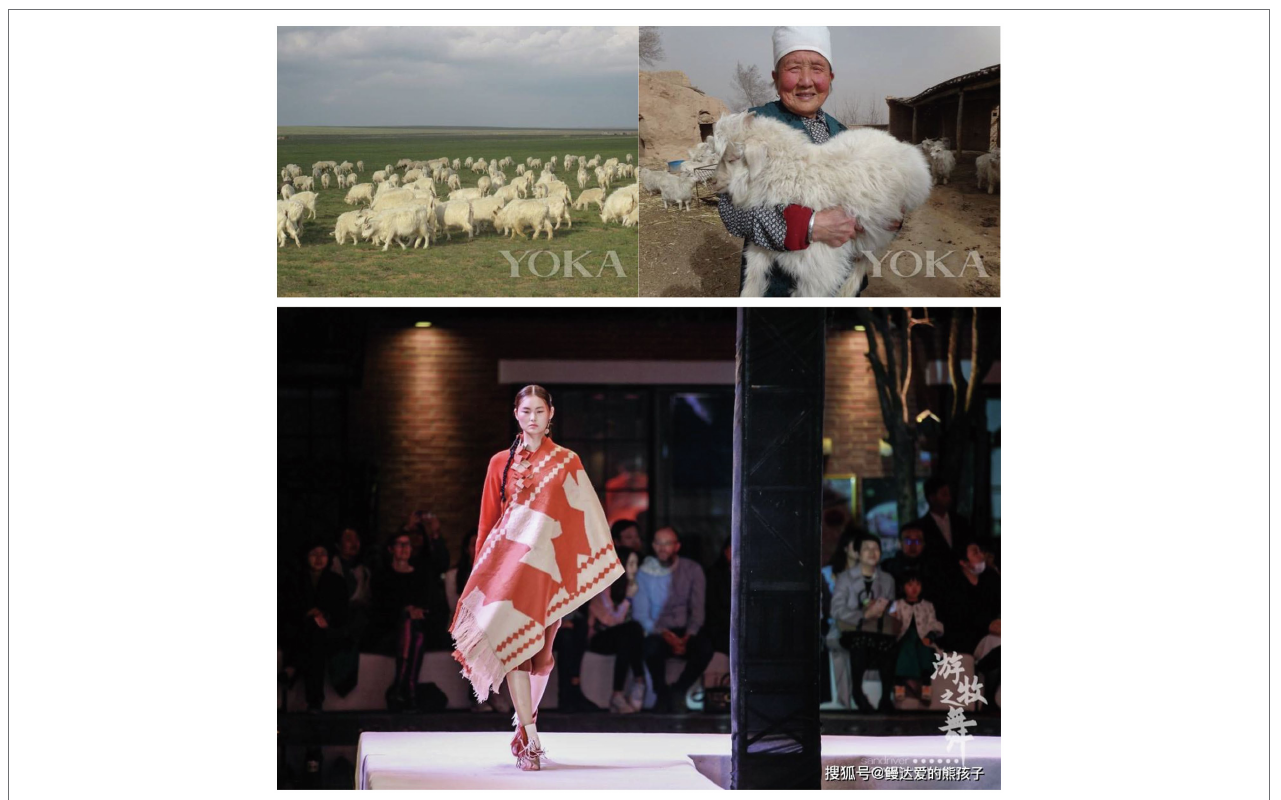
FIGURE 1 | Findings. The three photos displayed were all taken and kindly provided by Sand River’s CEO Mrs.